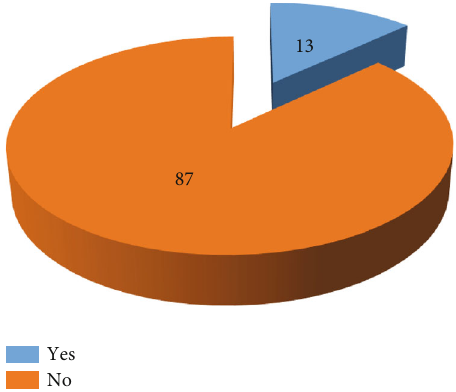
Figure 1: Level of social support among prisoners in Mekelle General Prison Center, Tigray, Ethiopia, 2019 ( n = 408 ). Figure 2: History of childhood abuse among prisoners in Mekelle General Prison Center, Tigray, Ethiopia, 2019 ( n = 408